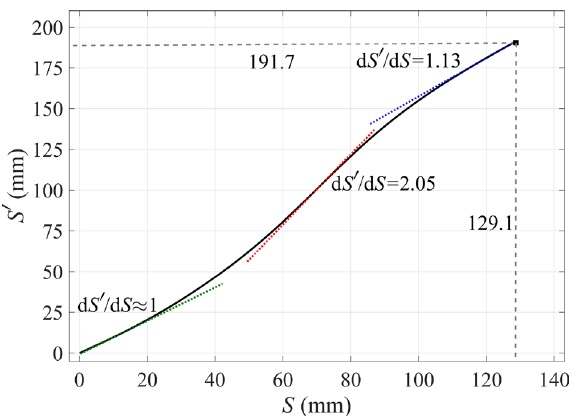
Figure 2. The rescaled optical path function S ′ ( S ) . The maximum value of S ′ is 192 mm, which equals the length of the ray b ′ c ′ in Fig. 1c. Also the maximum value of S is 129 mm that equals the length of the straight ray bc in Fig. 1a as required.